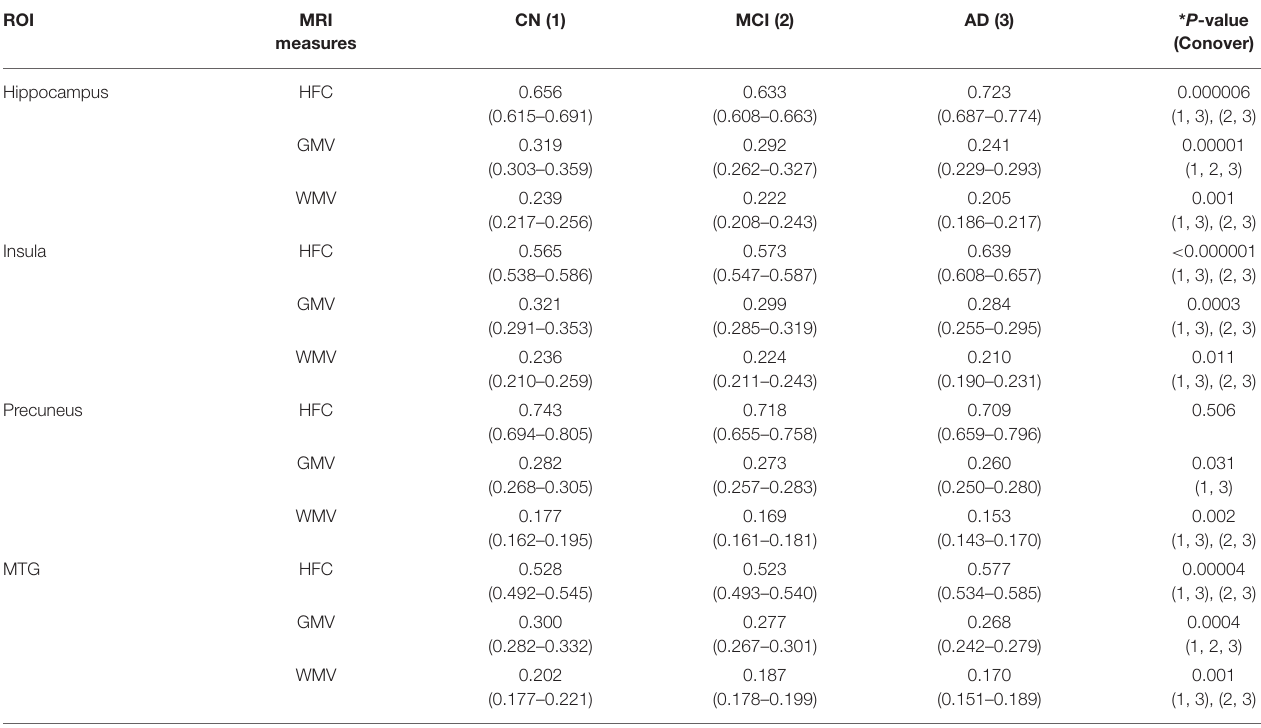
TABLE 2 | Results of comparisons of MRI measures among the three participants groups in the specific brain areas. ROI MRI CN (1) MCI (2) measures